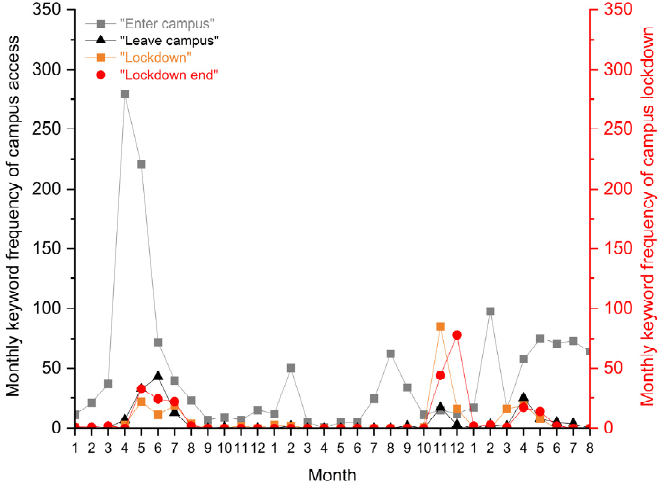
Figure 5. Monthly keyword frequency about campus access control: “Enter campus”, “Leave campus”, “lockdown”, and “lockdown end”.